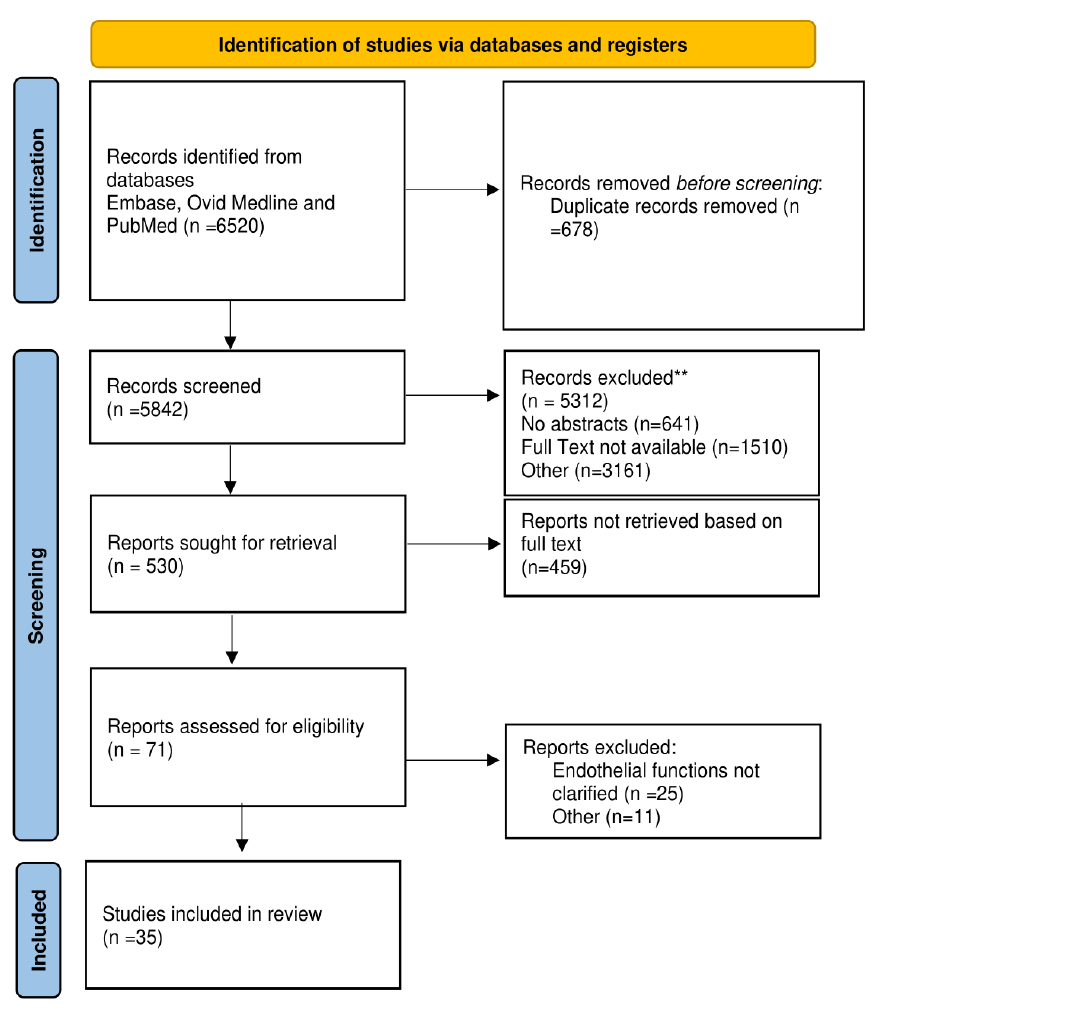
Figure 1. PRISMA 2020 flow diagram for new systematic reviews which included searchers of databases and registers only. From [MJ, McKenzie JE, Bossuyt PM, Boutron I, Hoffmann TC, Mulrow CD, et al. The PRISMA 2020 statement: an updated guideline for reporting systematic reviews. BMJ 2021 ;372: n71. doi : 10.1136/bmj. n71].